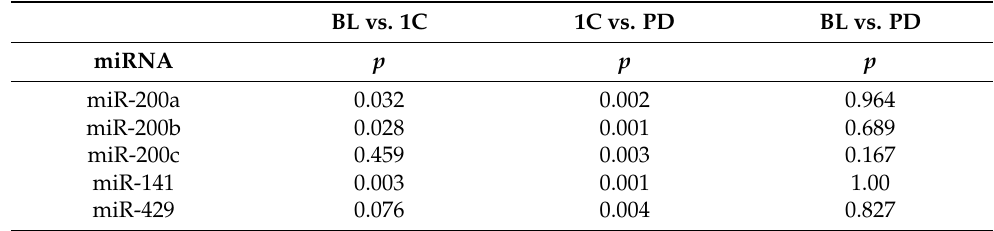
Table 1. Results of a pairwise t-test comparing the miRNA expression levels across measurements in time .